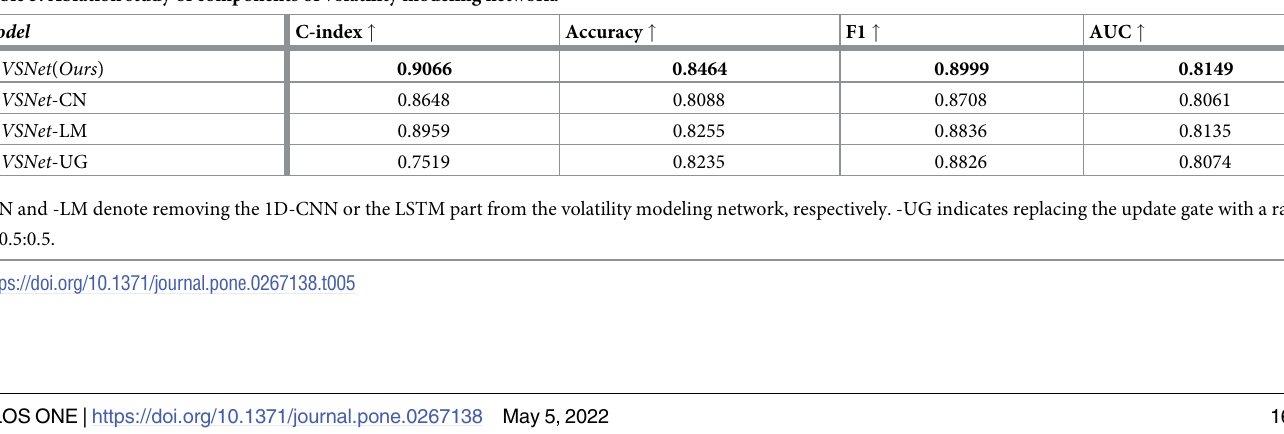
Table 5. Ablation study of components of volatility modeling